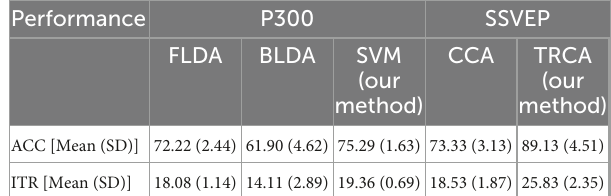
been used for the BCI for other purposes (Allison et al., 2014; Wang et al., 2015).